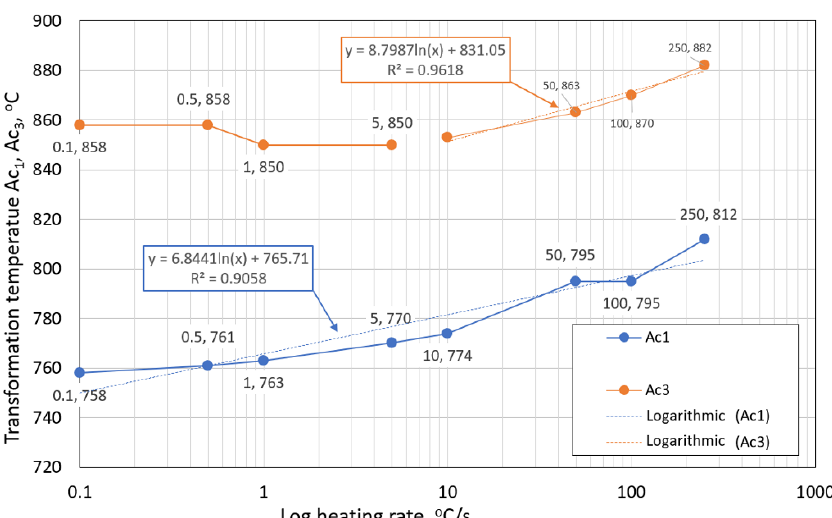
Figure 7. The influence of the heating rate on temperatures A c1 and A c3. The austenitic transformation (A c1 temperature) increases with an increased heating rate. This trend was observed in other works [36,43]. The A c3 temperature, when complete austenitization is achieved, was almost constant up to a heating rate of 10 ◦ C/s. At heating rates higher than 10 ◦ C/s, it began to grow. The differences between A c3 and A c1 decreased with an increased heating rate, as shown in Figure 8. The phenomena described are important in creating the width of the heat-affected zone and welding process modeling.